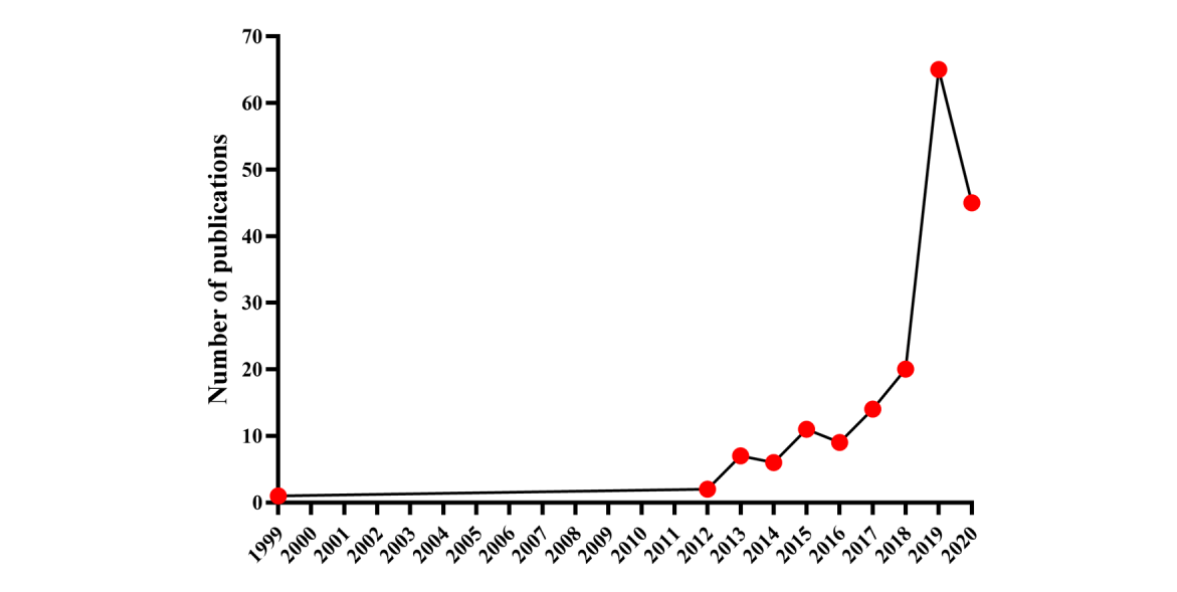
Figure 7. The trends in publications with international cooperation using the Surveillance, Epidemiology, and End Results database between 1999 and